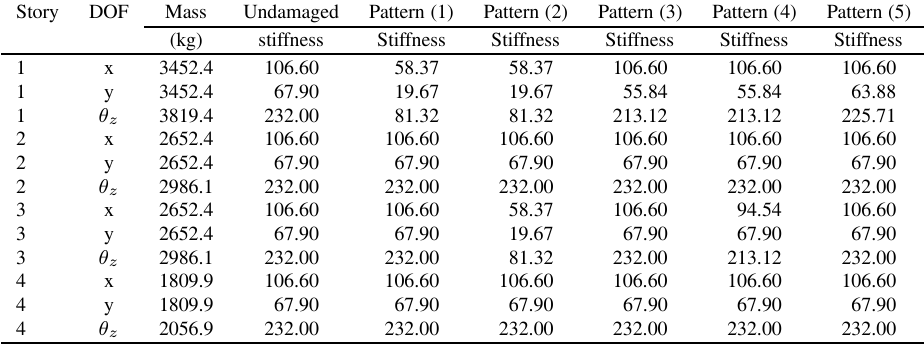
Table 1 Mass and horizontal story stiffness (MN/m) of undamaged and damaged 12 DOF model